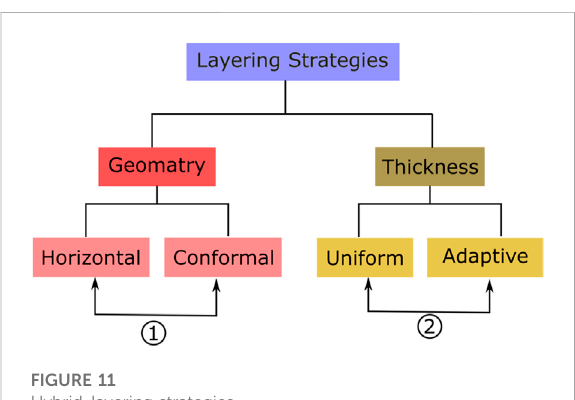
FIGURE 11 Hybrid-layering